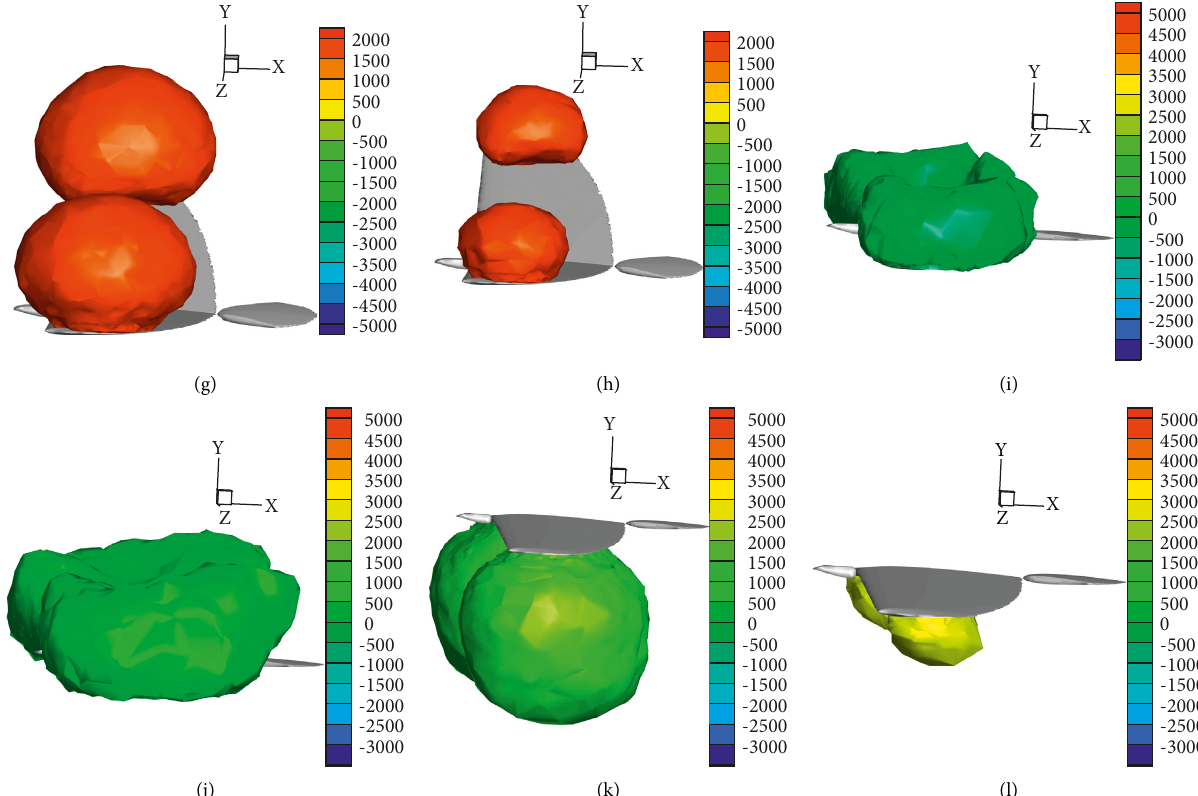
Figure 9: Pressure iso-surfaces of the flapping wing robot. (a), (b), (c) and (d):static pressure P � − 4, − 1, 1, and 4 (Pa) in the steady static; (e), (f), (g) and (h): static pressure P � 0, 1200, 1850 and 2000 (Pa) when the wing flaps upwards; (i), (j), (k) and (l): static pressure P � 0, 1000, 2000 and 3000 (Pa) when the wing flaps